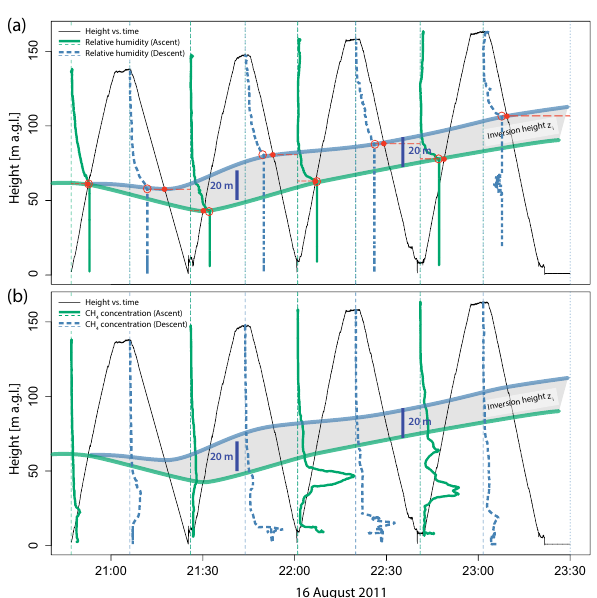
Figure 4. Inversion height z i (a) approximated via the profile of relative humidity for ascents (bold solid lines) and descents (bold dashed lines) during the first four nocturnal tethered balloon profiles and (b) with vertical profiles of CH 4 concentrations superimposed. The balloon height is shown as a time trace (black line). The relative humidity was 100% at the ground surface and the minimum value observed in a profile was used as a reference (thin dashed vertical lines) placed at the time point of the beginning of ascents and de- scents respectively. The large and small red circles in (a) link the rel- ative humidity showing the top of the saturated surface layer (large circles) with the corresponding height and time point on the black curves (small circle with red horizontal dashed line). The inversion height z i is derived separately for ascents and descents, yielding the grey band of showing an uncertainty on the order of 20–30m for z i